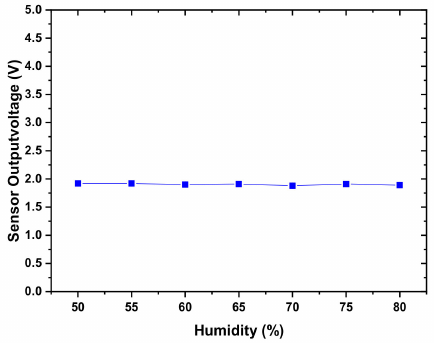
Figure 22. The voltage output of the sensor in response to humidity changes.